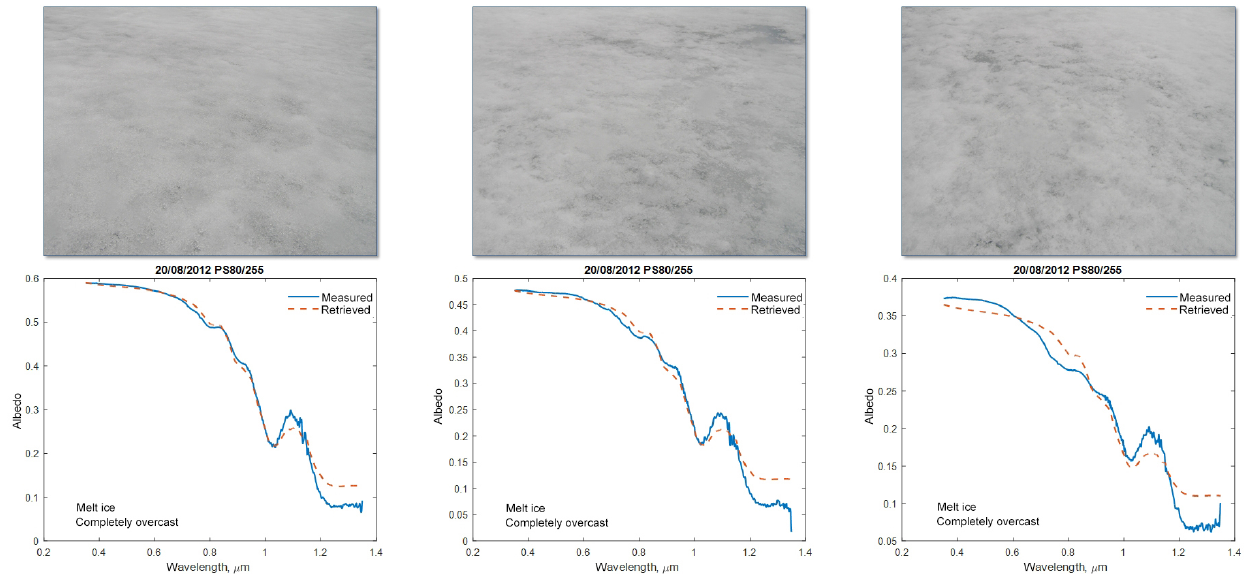
Figure 10. Melt ice. Melting (wet) scattering layer with depth of 1.5cm (left panels) and 7cm (the others). The degree of melting increases from left to right. The average air temperature is + 0.3 ◦ C.